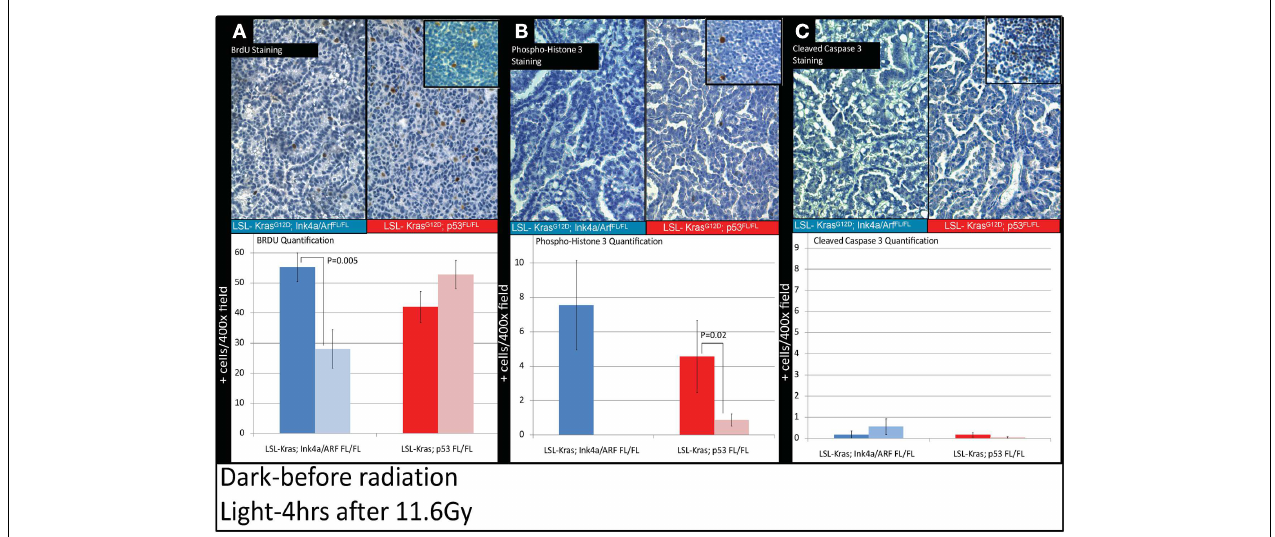
11.6Gy (200 × , brown-antibody immunostaining, blue – hematoxylin). Inserts show positive control staining for each antibody within unirradiated (BrdU or phospho-histone H3) and irradiated (cleaved-caspase 3) thymus. Bottom panels show quantification of immunohistochemical staining which was performed by counting the number of positively stained cells/random 400 × powered field within the lung tumor parenchyma. All analysis was done in a blinded fashion to treatment group and genotype. Error bars –